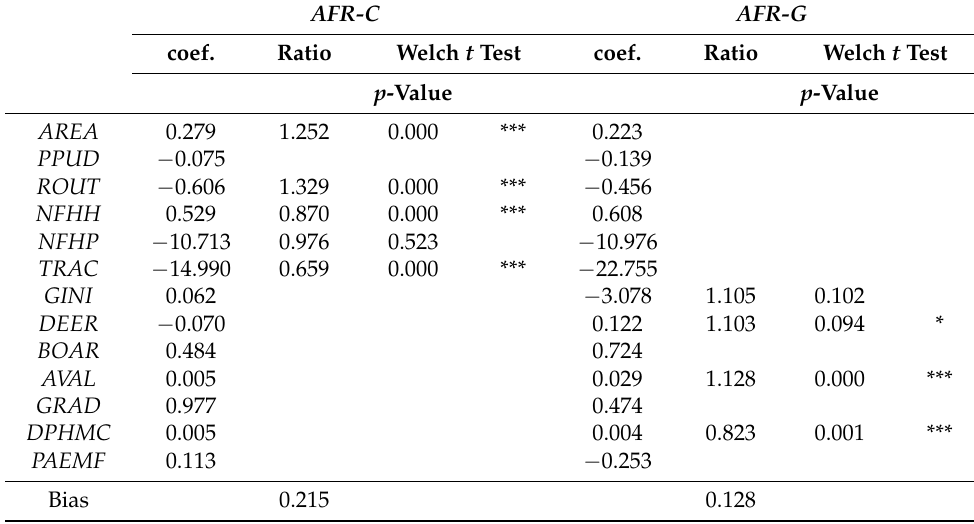
Table 4. Estimation result using ECD and performance comparison with ACD. AFR-C AFR-G coef. Ratio Welch t Test coef. Ratio Welch t Test p -Value p